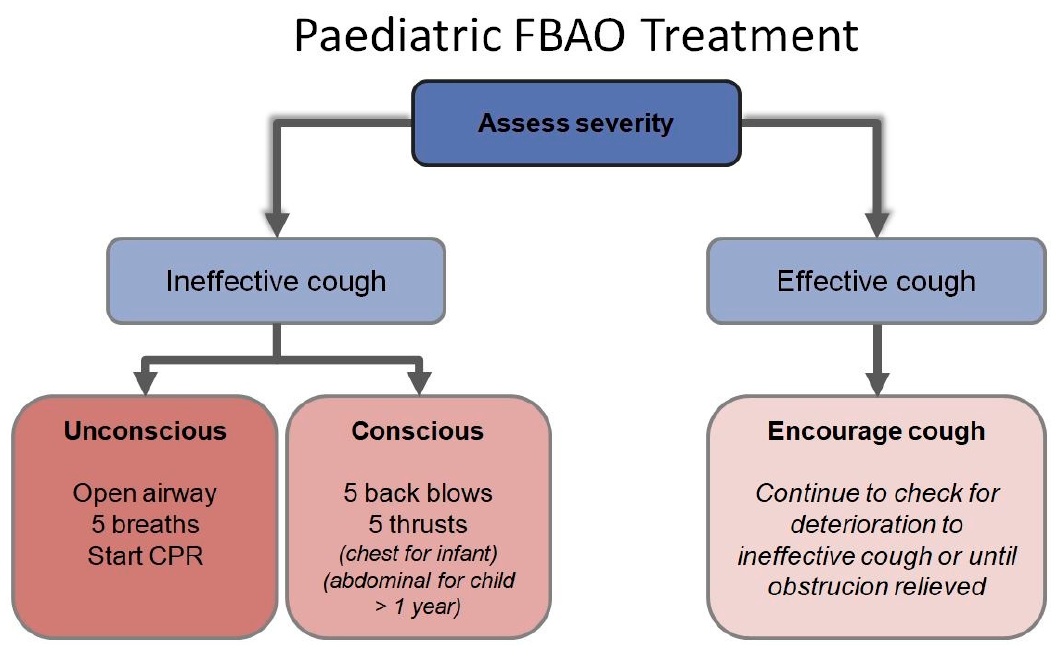
Figure1. Figure 1. Pediatric foreign body airway obstruction (FBAO) algorithm . CPR: Cardiopulmonary resuscitation.